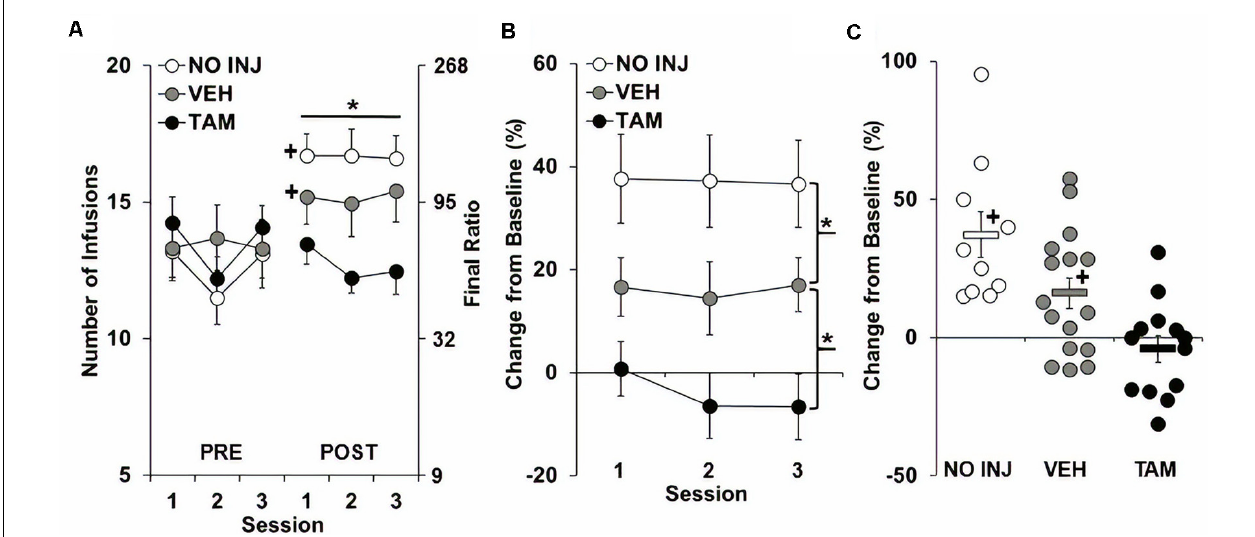
FIGURE 2 | Tamoxifen blocked the development of an enhanced motivation for cocaine. (A) Mean ( ± SEM) number of cocaine infusions obtained under the progressive-ratio (PR) schedule during each of the three sessions at baseline (PRE) and retest following ExA self-administration and abstinence (POST) for the no-injection (NO INJ; n = 10), vehicle (VEH; n = 16) and tamoxifen (TAM; n = 13) groups. ∗ Significant group effect ( P = 0.022); + Significant increase from baseline within the VEH ( P = 0.042) and NO INJ groups ( P < 0.001). (B) Percent change ( ± SEM) in the number of infusions obtained at retest following ExA self-administration relative to baseline (PRE) averaged across the three sessions. ∗ Significant difference between the NO INJ and VEH groups ( P = 0.044) and the VEH and TAM groups ( P = 0.019). (C) Scatterplot of each individual rats’ data for percent change in the number of infusions from baseline to retest. Solid bars represent the average values within each group ( ± SEM). + Significant increase from zero within each group (NO INJ, P = 0.003; VEH, P =